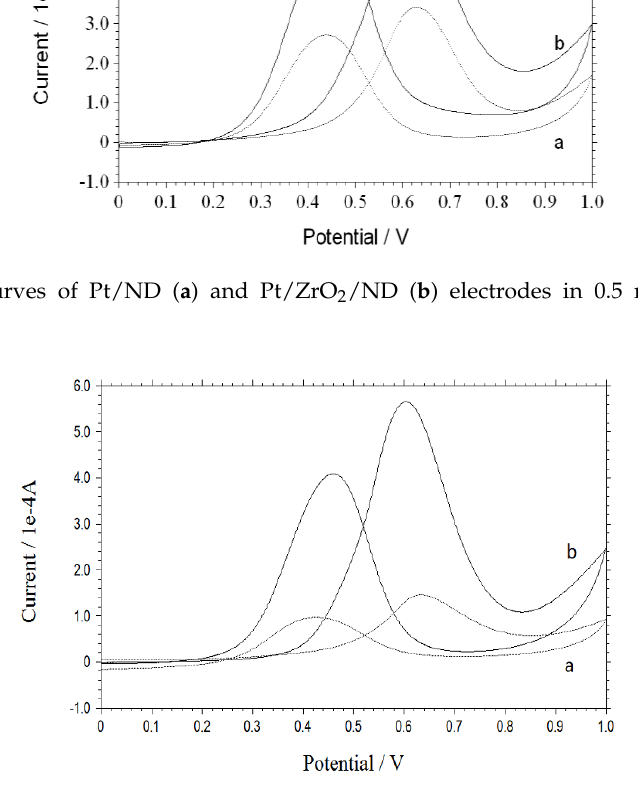
Figure 5. CV curves of Pt/ND ( a ) and Pt/ZrO 2 /ND ( b ) electrodes in 0.5 mol/L CH 3 OH + 0.5 mol/L H 2 SO 4 after 500 cycles.